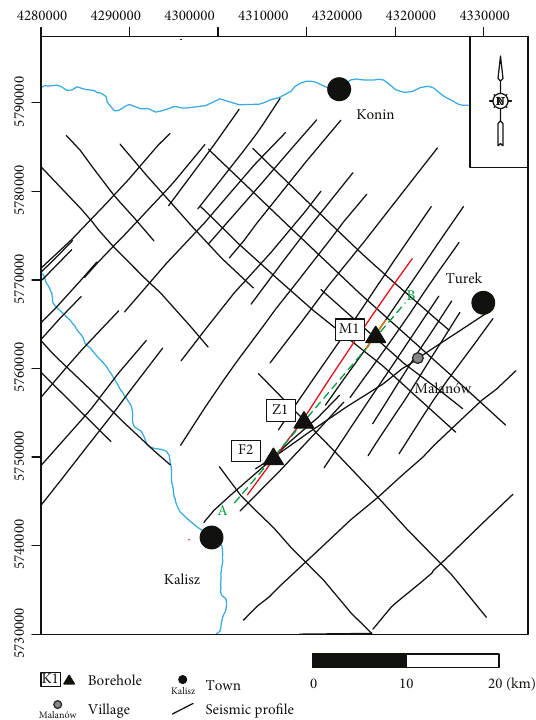
Figure 3: Map of the research area with location of deep wells and seismic pro fi les (correlated deep wells, along the green dotted line, are shown in Figure 2; orange part of the pro fi le is shown in Figure 4; red line pro fi le is shown in Figure